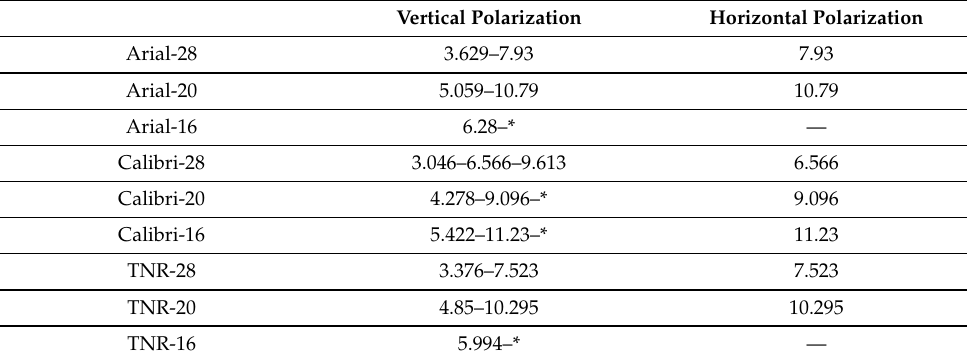
Table 7. Signature resonance frequencies for letter tag (cid:88) with various font types and sizes (* represents resonant frequency out of analyzed frequency range).